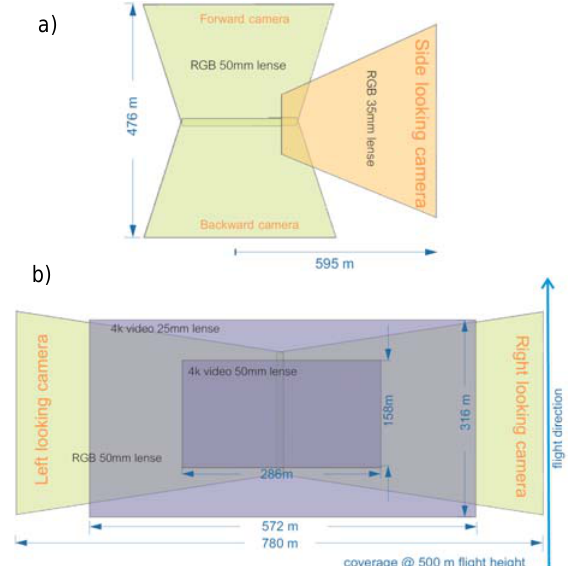
Figure 1: Footprints of a) CHICAGO and b) 4k sensor system based on a flight height of 500m